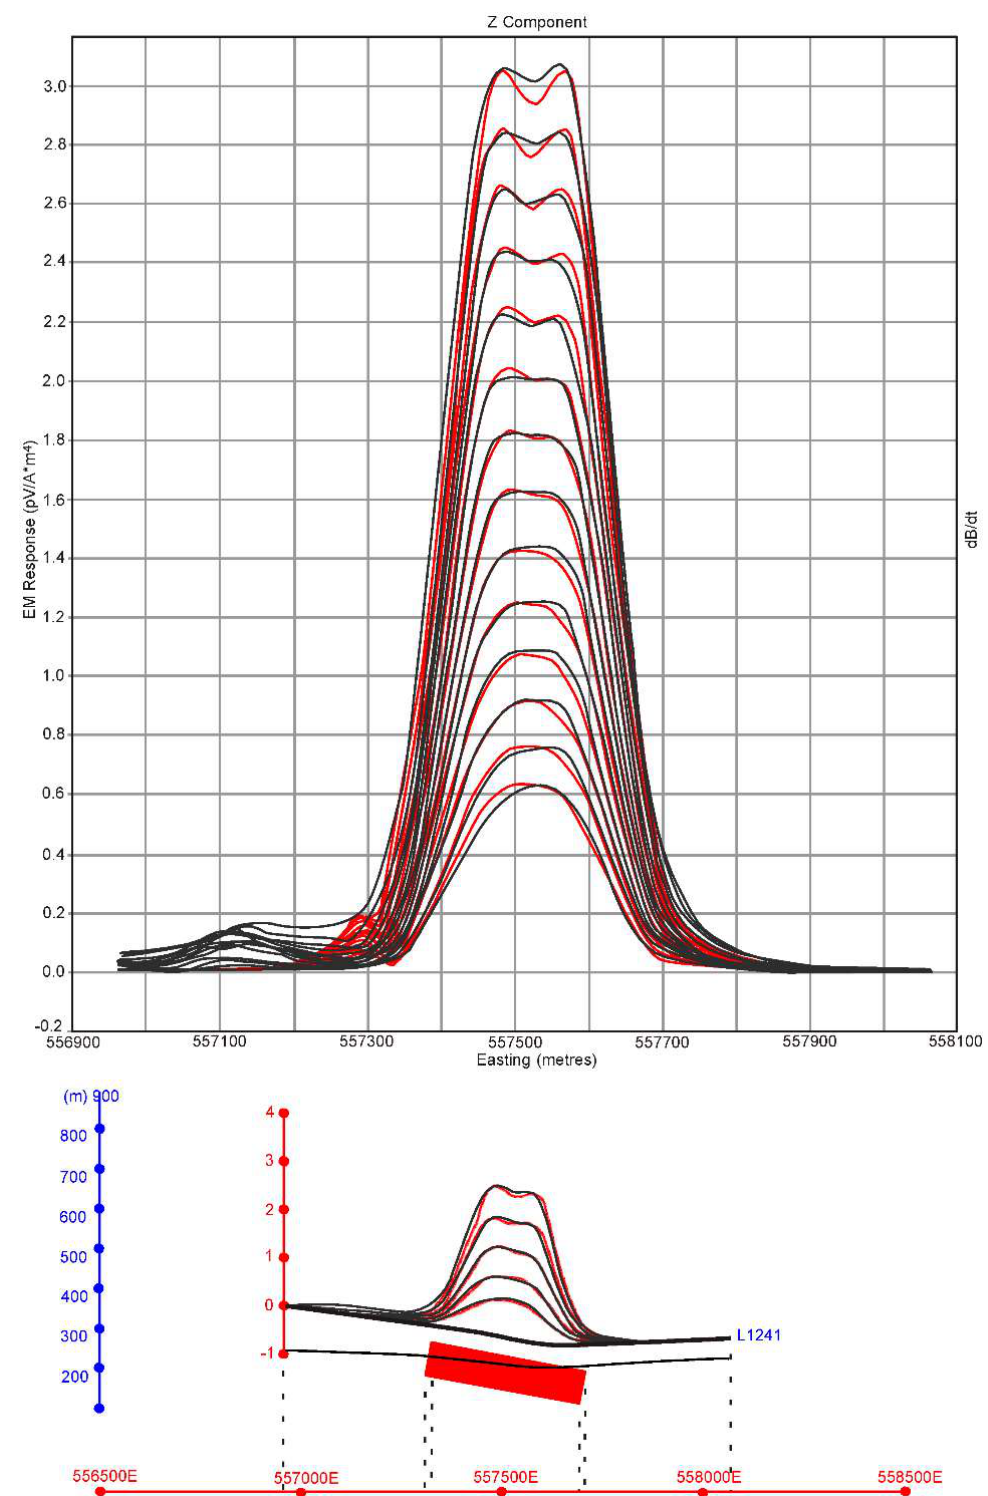
Figure 8. Maxwell thick plate modelling of the T-14 Target, facing north. The black lines are the field data of the Z component of the VTEM flight line L1241-1 and the red lines indicate the signals from the modelled plate. The top of the modelled conductor is close to surface and dips 10° east, with a conductance of 320S. It has a strike length of 370 m. In Figures 8–11, m means meters above sea level.